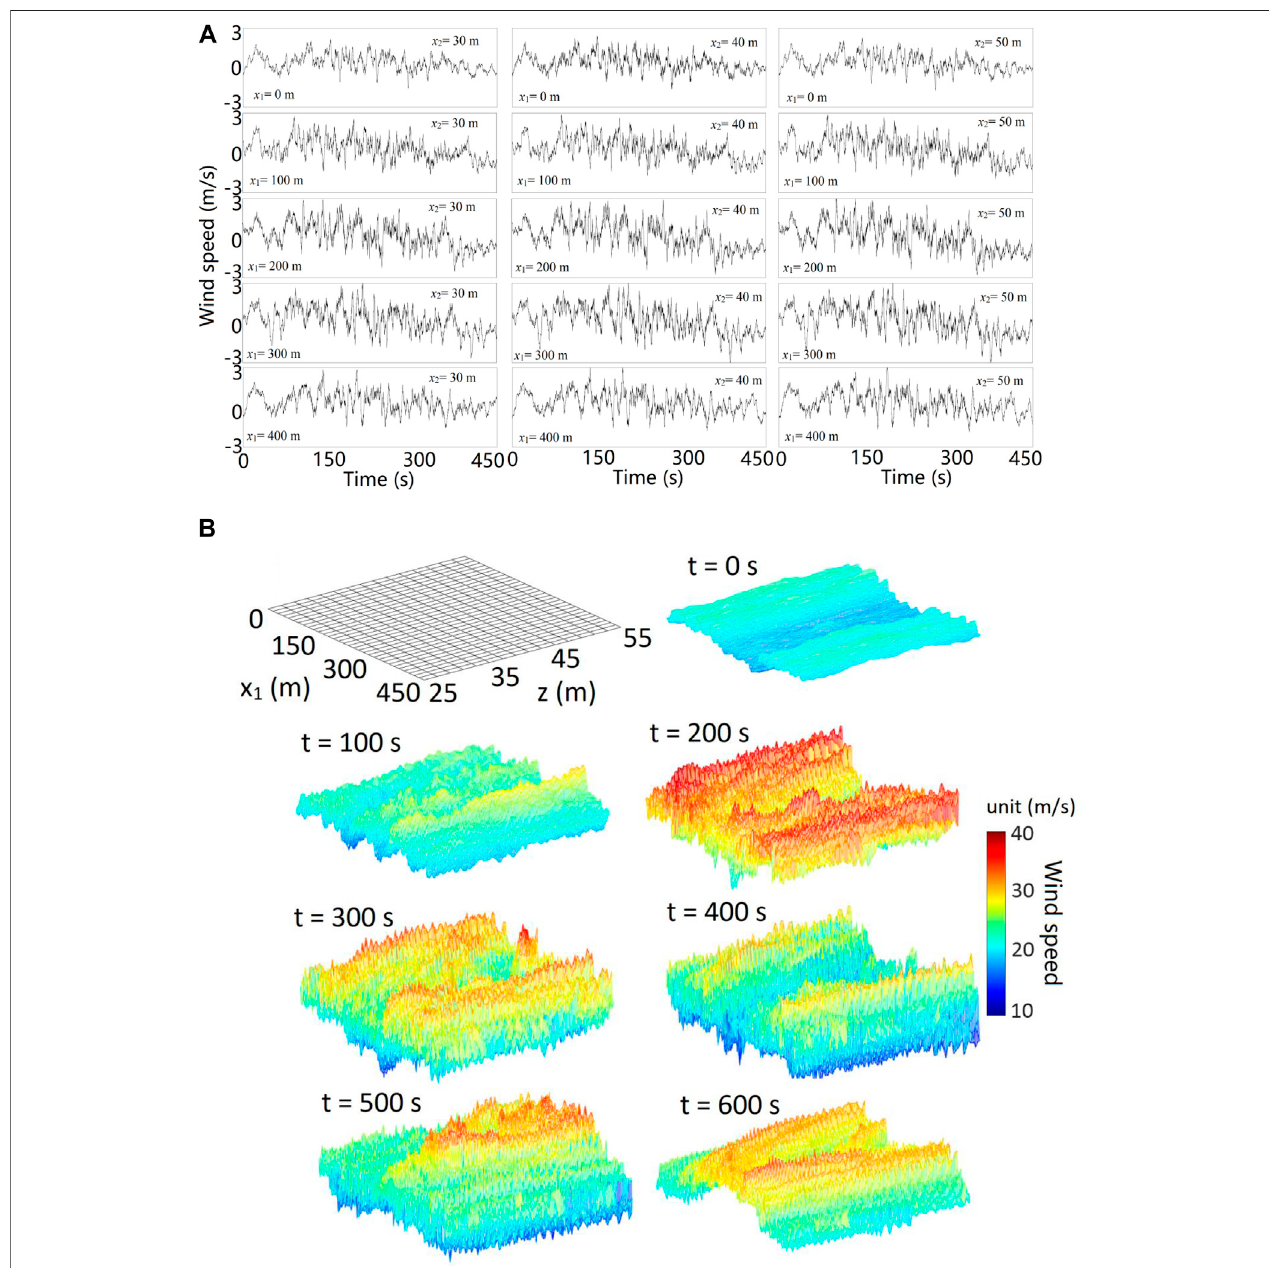
FIGURE 7 | (A) Plots of samples of simulated time histories for the nonstationary and (B) nonhomogeneous wind fi eld.